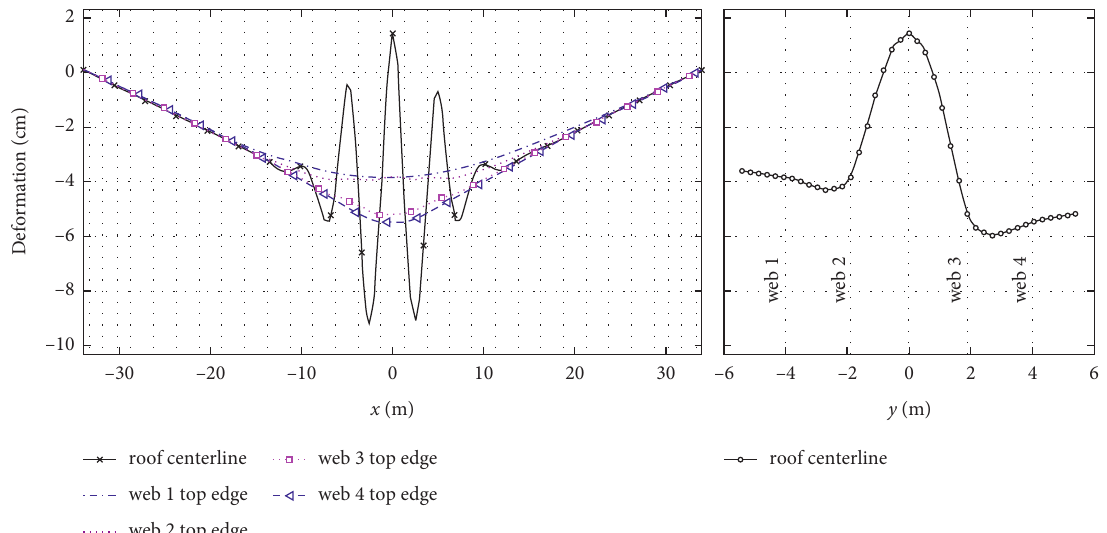
Figure 13: Roof deformation at failure.